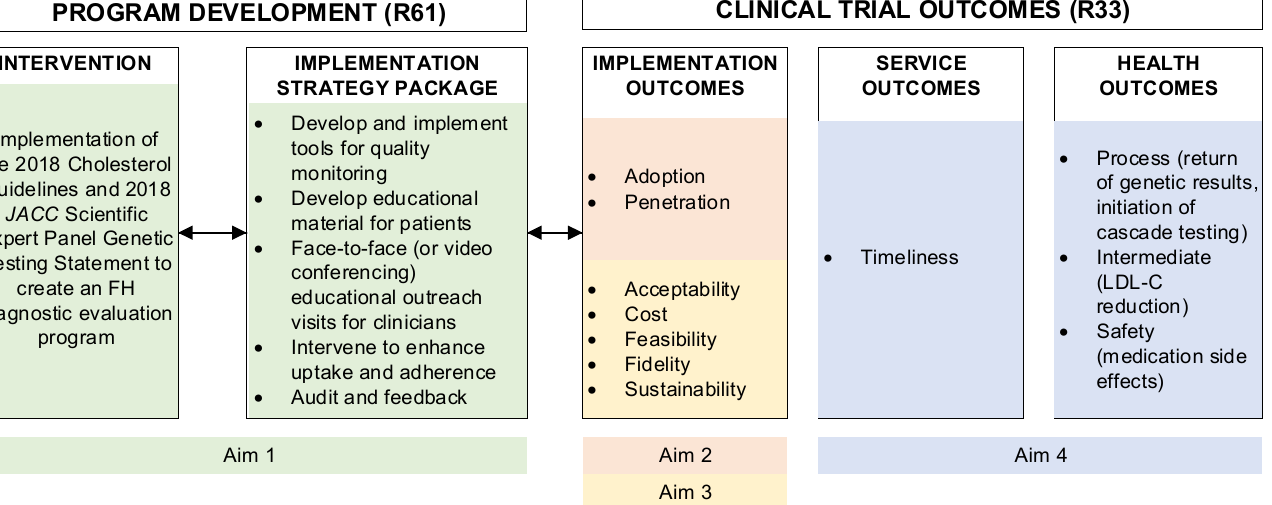
Figure 1. Conceptual model of implementation research framework tailored to the CARE-FH protocol. JACC, Journal of the American College of Cardiology.